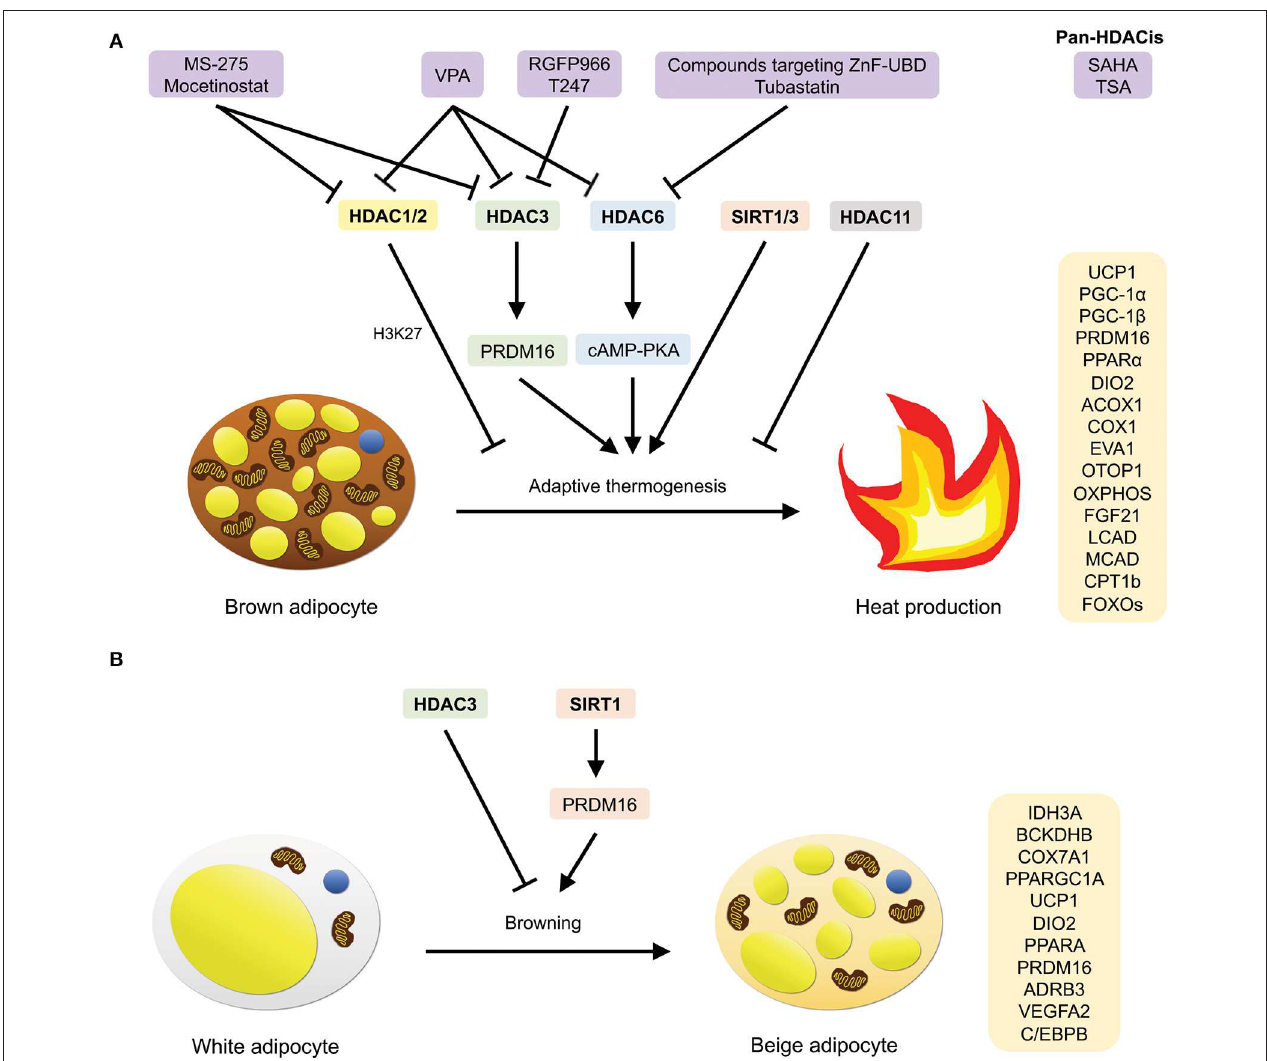
FIGURE 7 | HDACs that are involved in adaptive thermogenesis and browning, as well as compounds (HDACis) that have been demonstrated to inhibit them. (A) HDAC1/2/3/6/11 and SIRT1/3 mediate adaptive thermogenesis by inducing the expression of BAT-specific, thermogenic, lipid β -oxidation, and transcription regulation-related genes. (B) HDAC3 and SIRT1 mediate browning of white adipocytes by inducing the expression of oxidative metabolic genes and classical BAT markers.